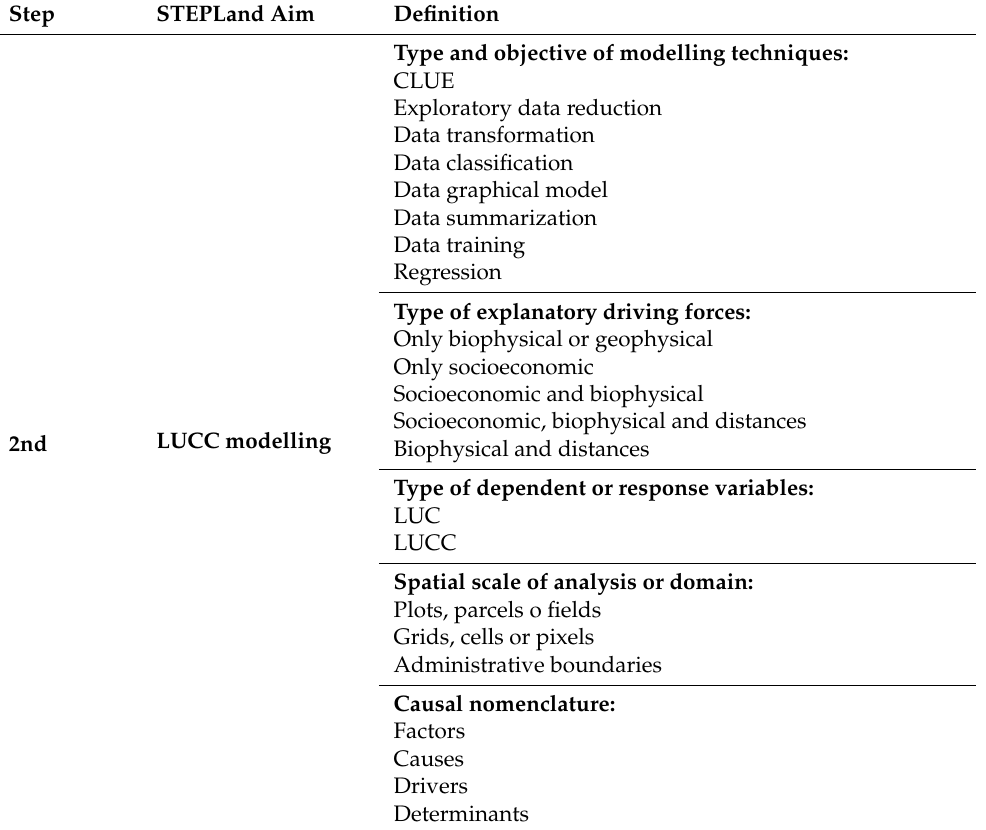
Table 2. Parameters collected in the second STEPLand step, corresponding to “LUCC modeling”.